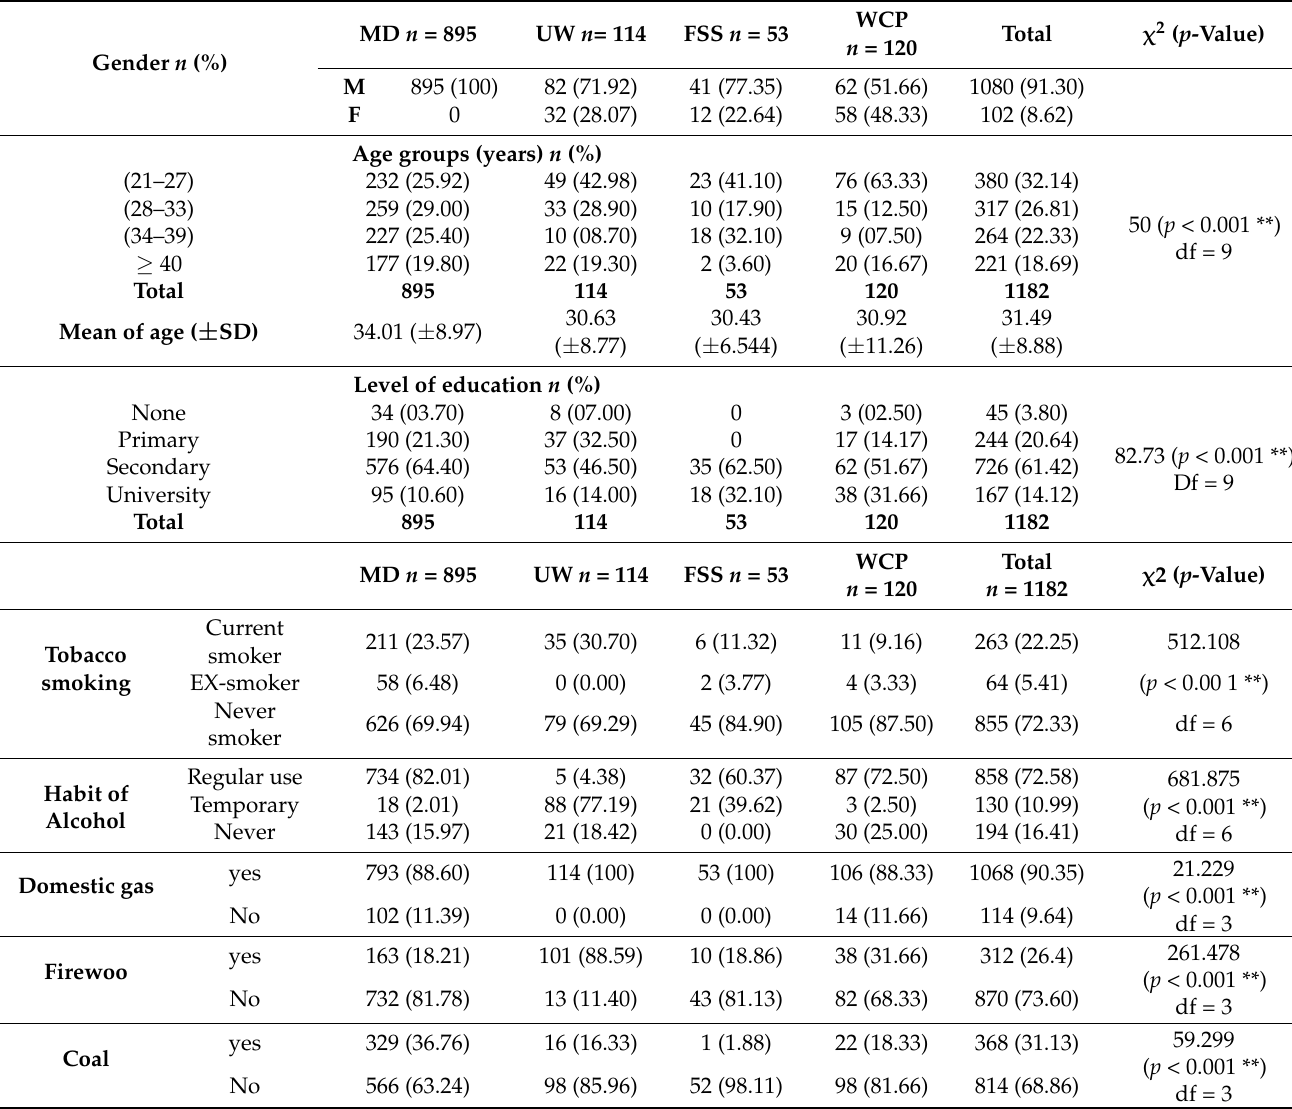
Table 1. Baseline characteristics of participants.